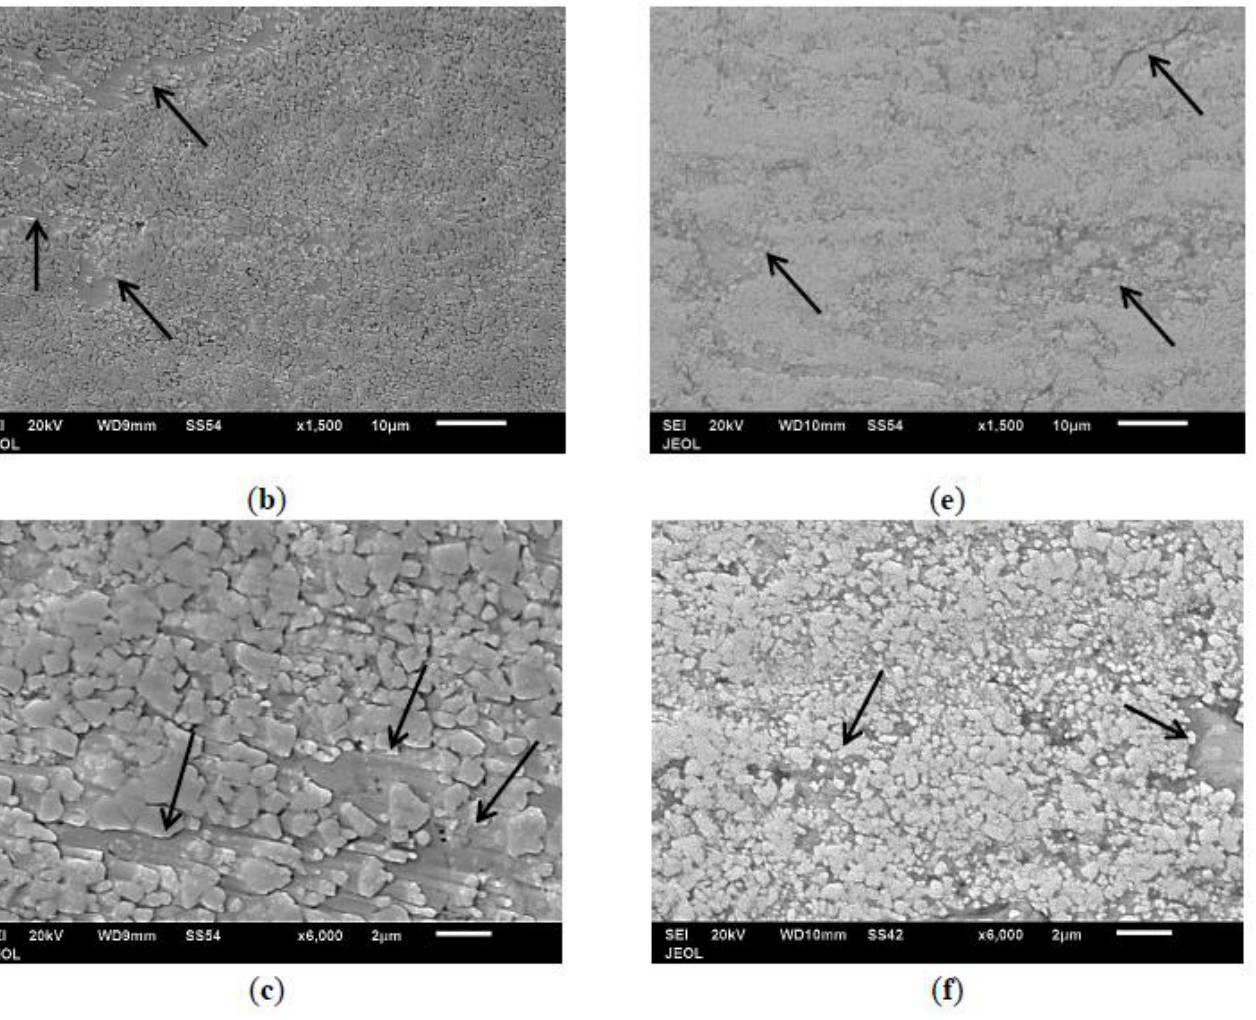
Figure 7. Coating layer at different magnifications of WC-12Co ( a – c ) and WC-10Co-4Cr ( d – f ) Note: black arrows point at the pullout zones.